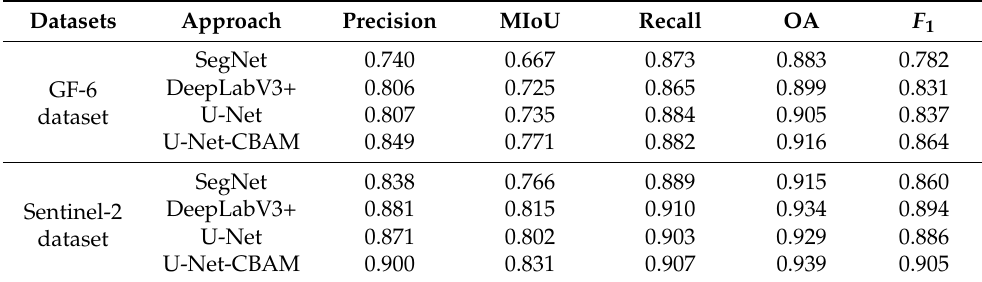
Table 5. Extraction accuracy of winter-wheat planting